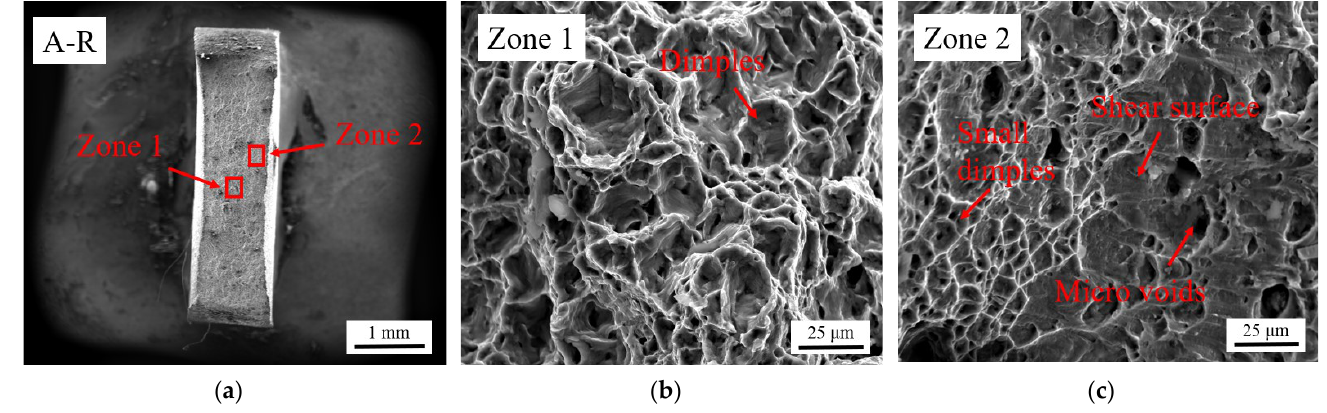
Figure 17. Fractography analysis of A-R material sample: ( a ) Selected areas showing type of fracture at middle (Zone 1) and edge of fracture face (Zone 2); ( b ) High magnification of Zone 1; ( c ) High magnification of Zone 2.